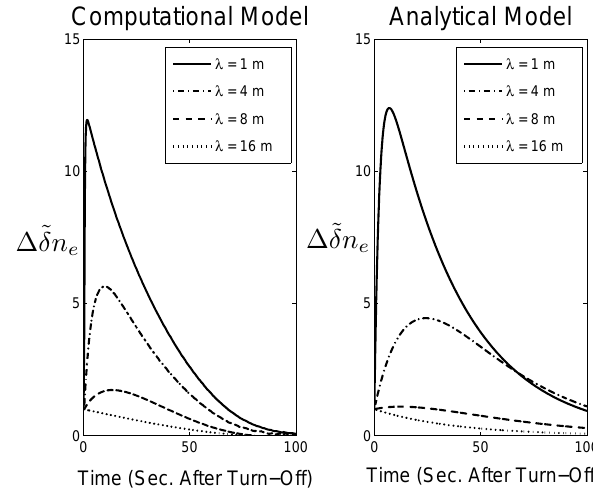
Fig. 3. Schematic of electron irregularity behavior subsequent to radiowave heating.